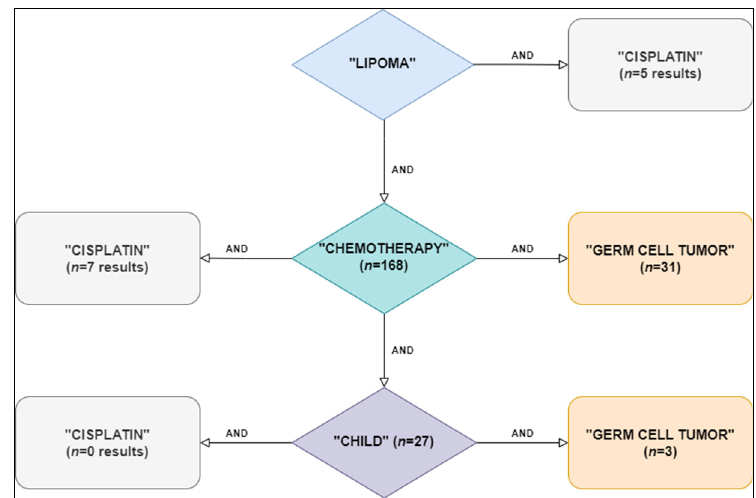
Figure 4. Flowchart of steps and keywords used for database search.